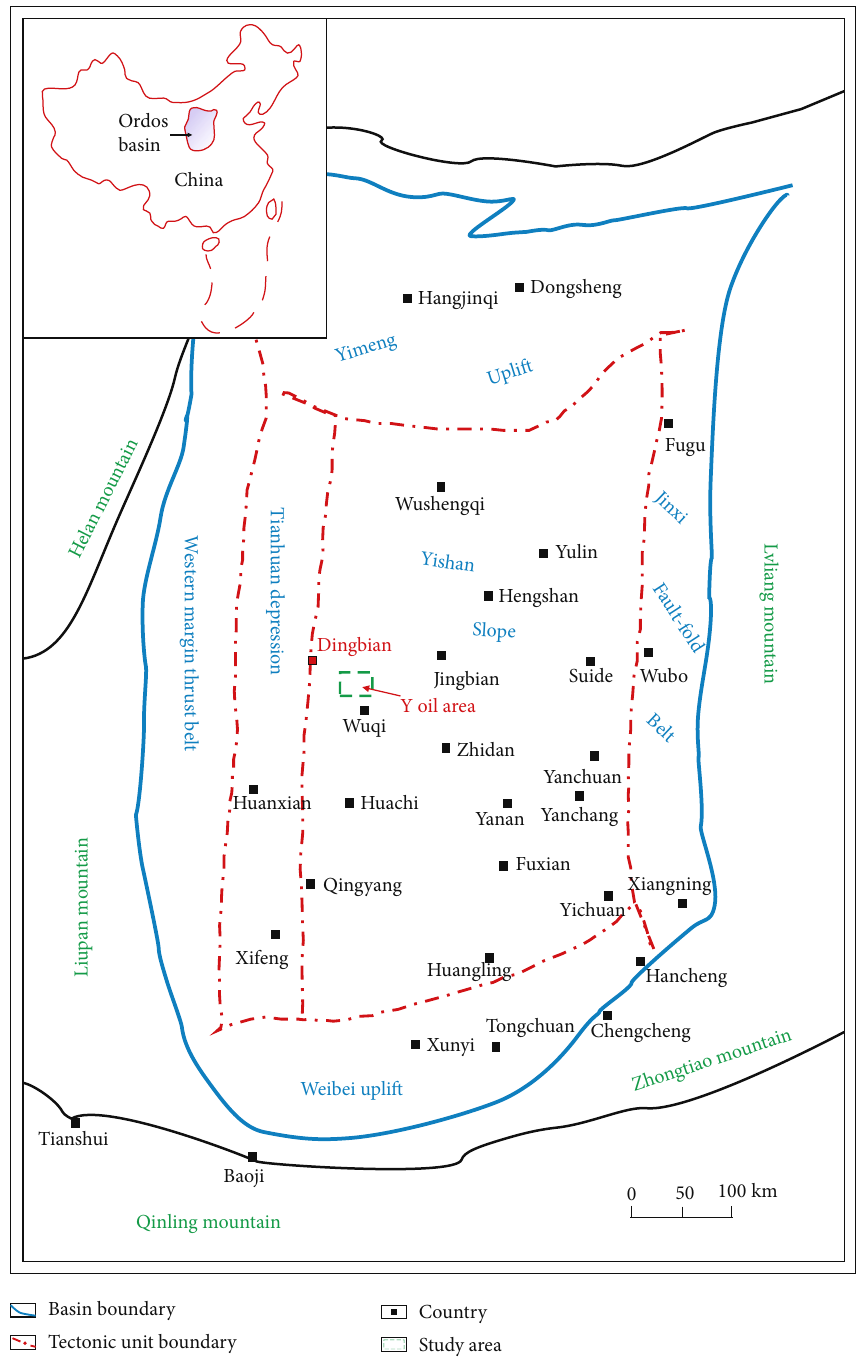
Figure 1: Geographic location map of Dingbian Y oil fi eld in Ordos